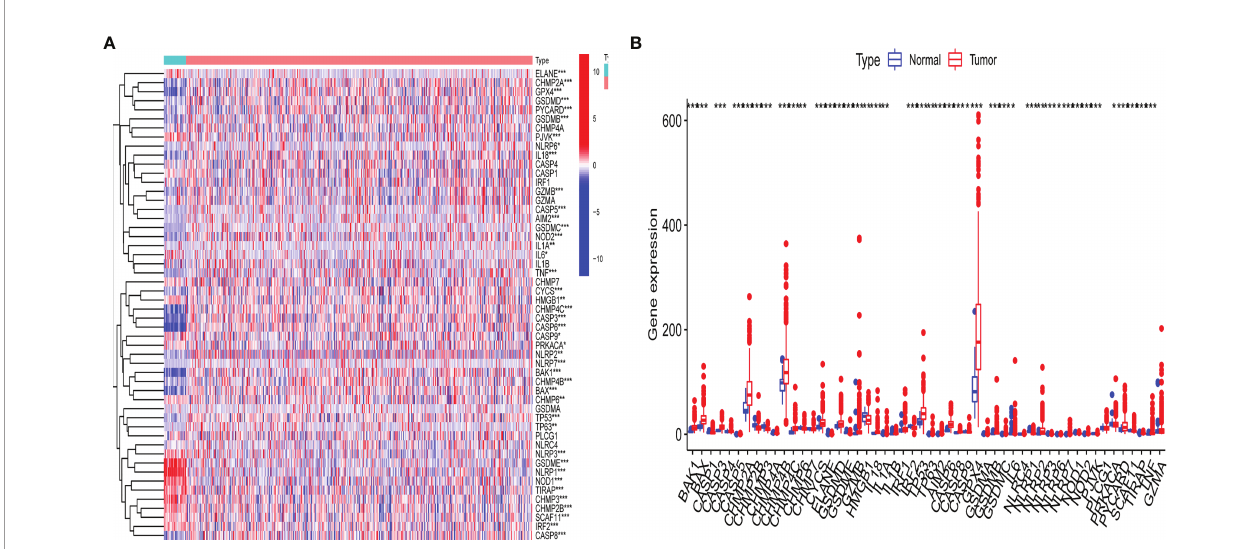
FIGURE 1 | Expression of pyroptosis-related gene in uterine corpus endometrial carcinoma (UCEC). (A) Heatmap of expression levels of 47 pyroptosis-related genes. P-values are shown as: *p < 0.05; **p < 0.01; ***p < 0.001; (B) Boxplot of expression levels of 47 pyroptosis-related genes. P-values are shown as: *p < 0.05; **p < 0.01; ***p <